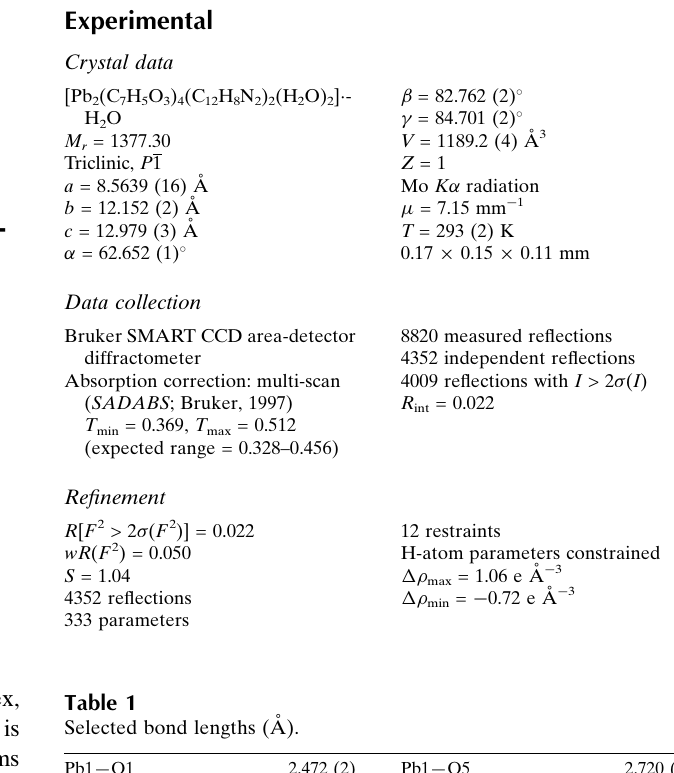
N environment by two N atoms 6 2